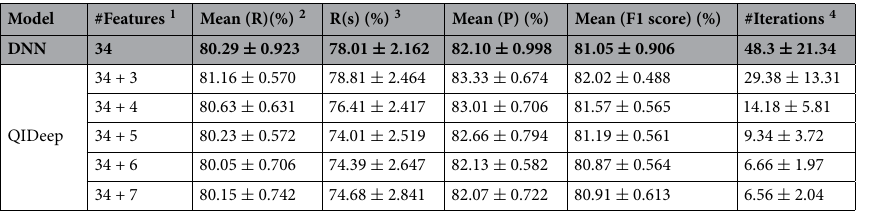
Table 3. Influence of The Number of Interaction Features on Performance of QIDeep. 1 #Features: number of features. 2 Mean(X): mean of X on all four states, for X ∈ { Precision, Recall, F1 score } . 3 R(s): recall of the attack state. 4 #Iteration: number of